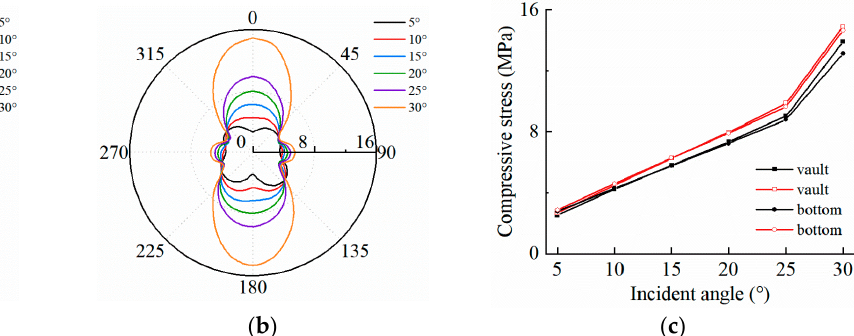
Figure 12. Compressive stress at each section (MPa): ( a ) stress envelopes at Section 1 ‐ 1, ( b ) stress envelopes at Section 6 ‐ 6, and ( c ) curves of compressive stress of the vault and bottom (black line indicates the points of Section 1 ‐ 1, and the red line indicates the points of Section 6 ‐ 6). Figure 12 shows the compressive stress envelopes and stress curves of the vault and bottom. In Figure 12a, the stresses increase obviously with the increase in the incident angle, the stress distribution changes from a four ‐ leaf clover to a dumbbell. The stresses of the vault and bottom are greater than other locations. When the incident angle is 30°,